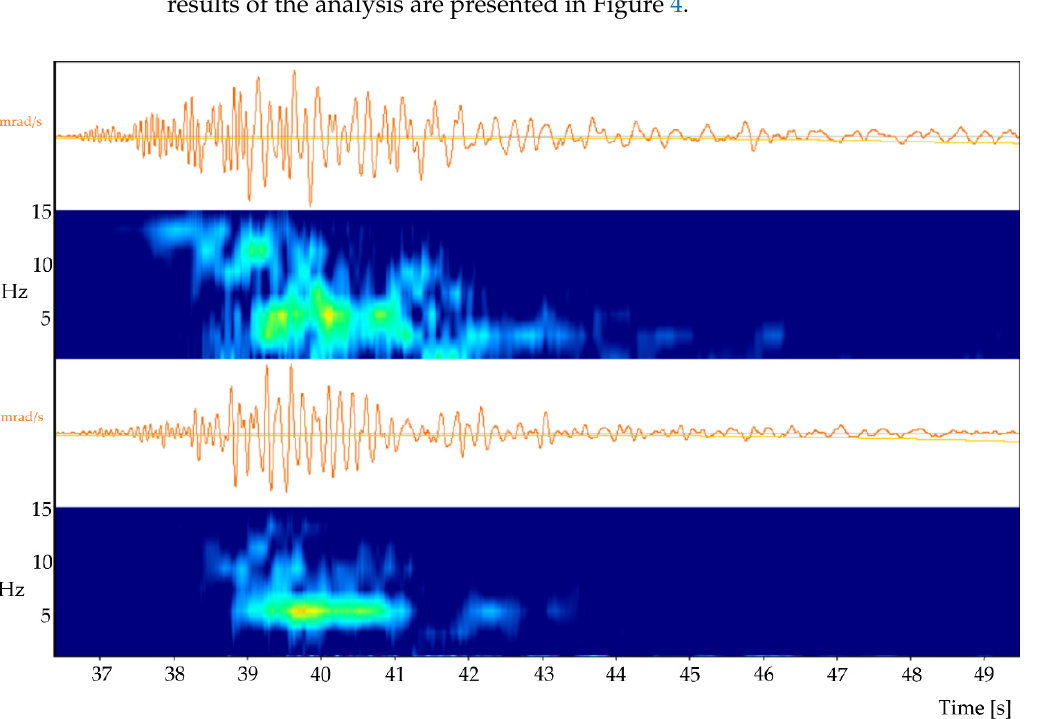
Figure 4. Time–frequency decomposition of the horizontal components of the rotational velocity records of the mining tremors for the energy of E = 3.1 × 10 8 J.